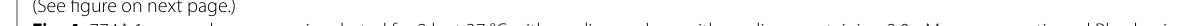
H6. a Fluorescence intensities of cell lysates were measured and normalized to total cell protein content. b Loosely packed cell pellets were generated and T1 values were measured using T1‑weighted MR imaging of cell pellets incubated with medium alone, dHDL mimicking NPs or sHDL mimicking NPs. c Normalized enhancement ratio (NER) values for cell pellets are calculated from corresponding T1‑weighted images and are relative to cells incubated with medium only. d Contrast‑to‑noise ratio (CNR) values for cell pellets are calculated from the corresponding T1‑weighted images and are relative to cells incubated with medium only. e Differential interference contrast (DIC) image of a single representative J774A.1 macrophage incubated with sHDL (similar images were obtained for dHDL). 4 ′ ,6‑diamino‑2‑phenylindole (DAPI) dye (blue), Dylight 488‑labeled peptide H4 (green), Rhodamine B‑labeled lipid (red) and merged image. f Representative axial T1‑weighted images of ApoE − / − mice, collected before (Pre) and 4 h, 24 h, 48 h and 72 h after administered with the equivalent of 0.05 mmol Gd kg − 1 of paramagnetic and